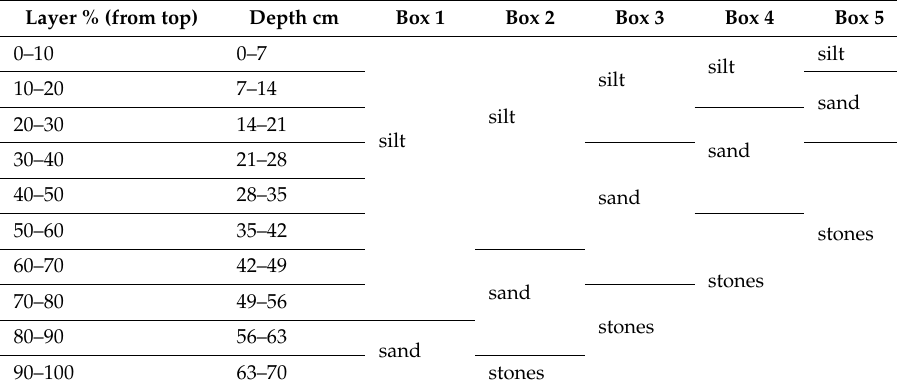
Table 1. Arrangement of the sediment layers in each